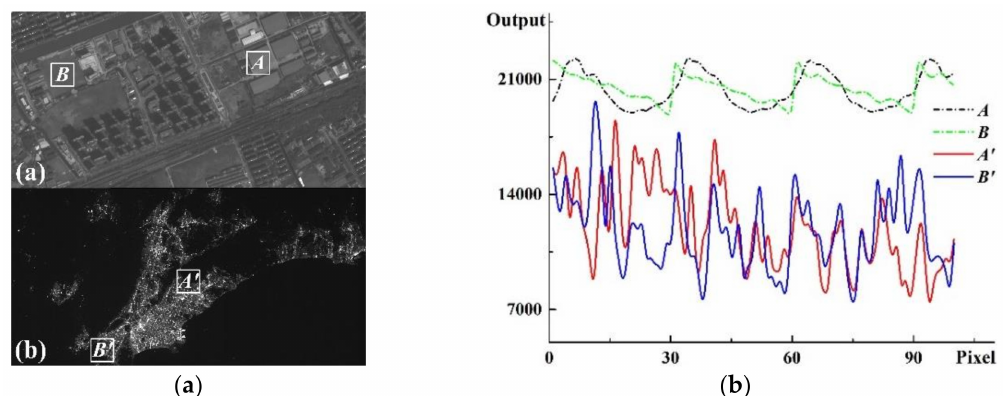
Figure 1. Comparison of ( a ) high-resolution image and low-resolution image and ( b ) the output values curves of 4 di ff erent regions from the two